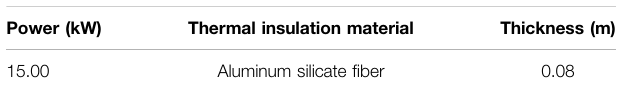
TABLE 1 | Detailed parameters of heater. TABLE 2 | Components of the typical industrial vacuum distillation